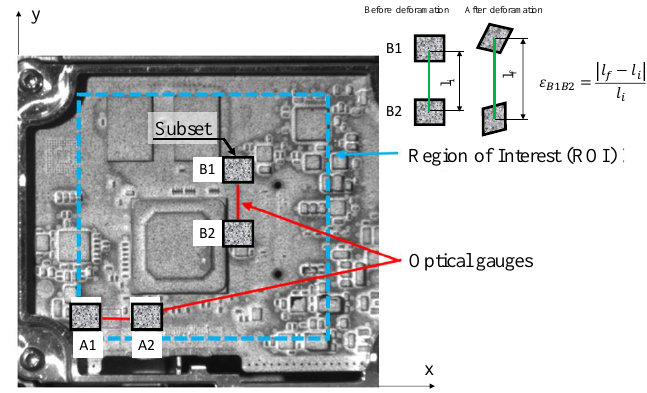
Figure 4. DIC measurement areas.